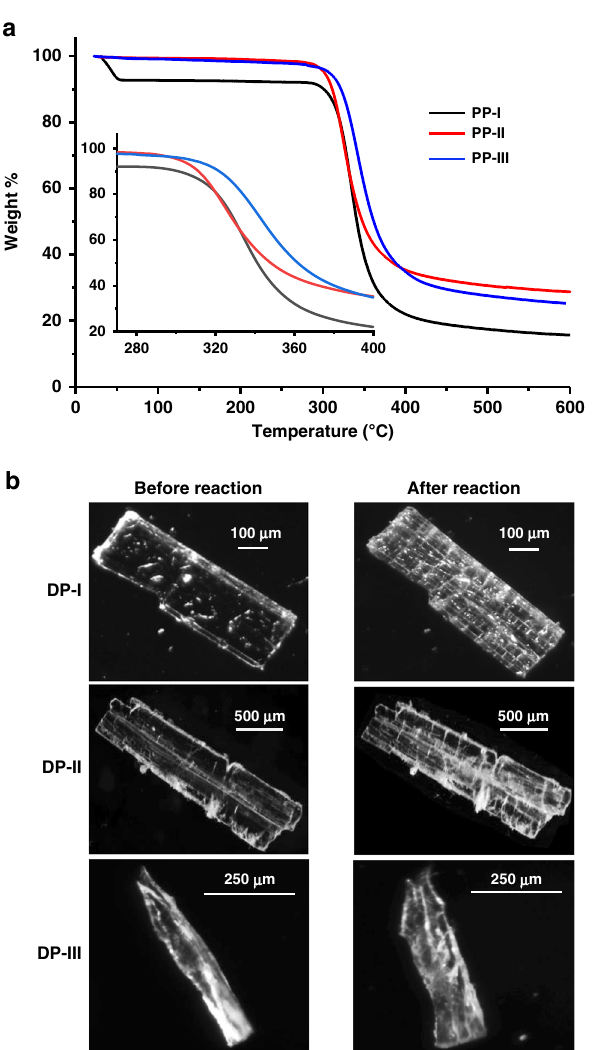
Fig. 5 Thermal stabilities of the pseudoproteins and the morphology changes due to TAAC reaction. a TGA comparison of the pseudoproteins PP-I (black), PP-II (red), and PP-III (blue). b Microscopic images showing cracking of crystals of all three polymorphs DP-I (scale bar = 100 µ m), DP- II (scale bar = 500 µ m), and DP-III (scale bar = 250 µ m) due to TAAC reaction. Source data are provided as a Source Data fi le for